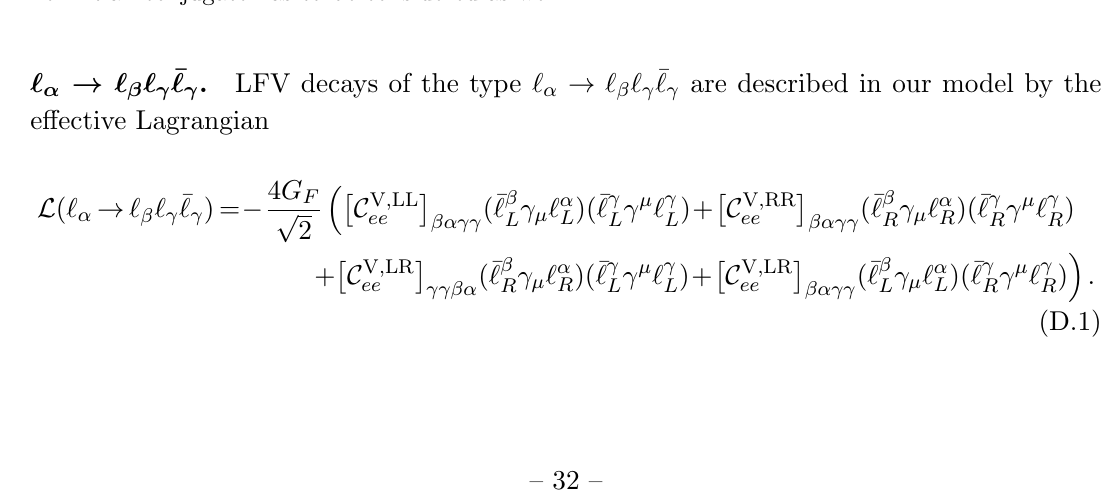
Table 6 . Wilson coe(cid:14)cients of four-fermion operators. For the operators denoted with a [*], the hermitian conjugate has to be considered as